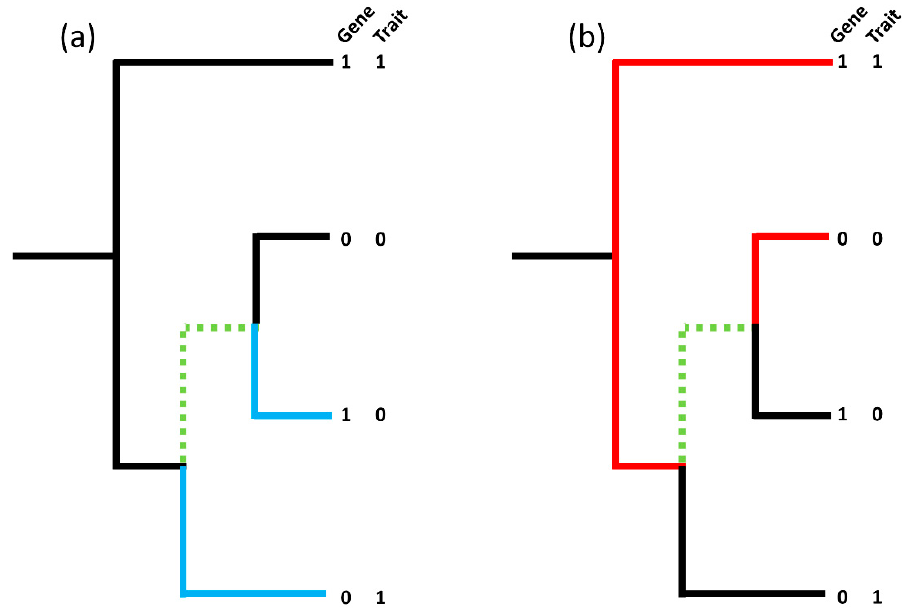
Figure 1. (Adapted from Brynildsrud et al. [32]). ( a ) shows one contrasting pair (blue branches; 1–0|0–1) whilst ( b ) shows another contrasting pair on the same tree (red branches; 1–1|0–0), however, the maximum number of non-intersecting, contrasting pairs in the tree remains as one due to the common branches, highlighted in green, shared by both contrasting pairs. The ‘best’ picking is the red pair with both the gene and the trait present whilst the ‘worst’ picking is the blue pair. To handle confounding by lineage a pairwise comparisons algorithm can be used to identify the maximum number of non-intersecting, contrasting pairs in a tree and calculates the corresponding binomial test p -value taking into account the proportion of ‘best’ and ‘worst’ pickings over the set of non-intersecting, contrasting pairs.